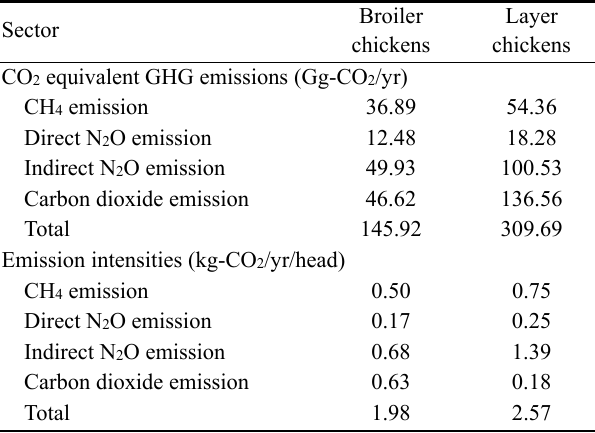
Table 3. Average CO 2 equivalent GHG emissions (Gg-CO 2 /yr) and emission intensities (kg-CO 2 /yr/head) in broilers and layers